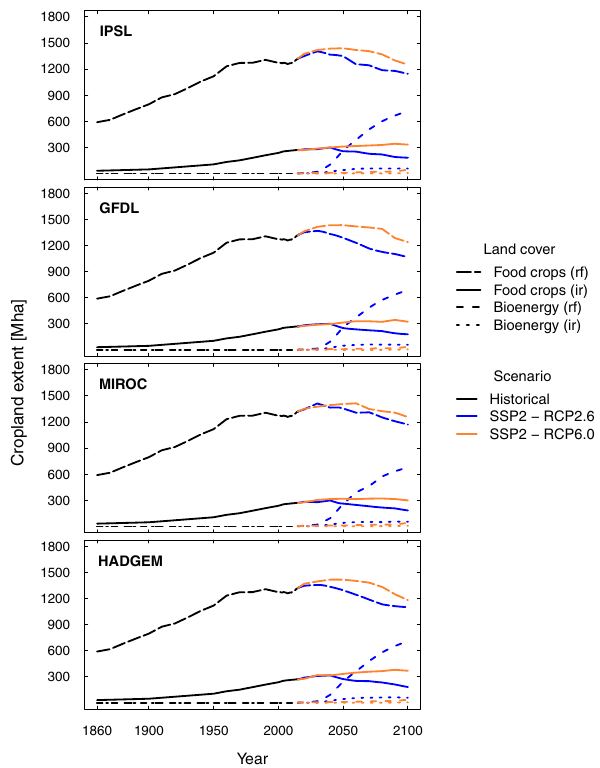
Figure 3. Time series of total cropland for food–feed production (rainfed (long-dashed lines) and irrigated (solid lines)) as recon- structed for the historical period (1860–2015) based on HYDE3.2 (Klein Goldewijk, 2016) and projected under SSP2 (2016–2099), assuming no explicit mitigation of greenhouse gas emissions (RCP6.0, yellow line) and strong mitigation including land-based mitigation (RCP2.6, dark blue line) as suggested by MAgPIE and harmonized according to (Hurtt et al., 2017). Future projections also include rainfed (dashed lines) and irrigated (dotted lines) land areas for bioenergy trees and grasses for the demand generated from the Integrated Assessment Modelling Framework REMIND-MAgPIE in the SSP